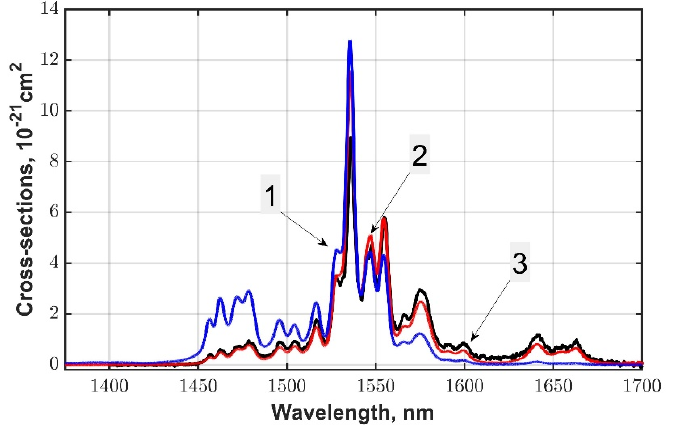
Figure 8. Absorption (1, blue) and emission (2, red; 3, black) cross-section spectra of Er 3+ :Y 2 O 3 optical ceramics. 2—MRM; 3—FLE.